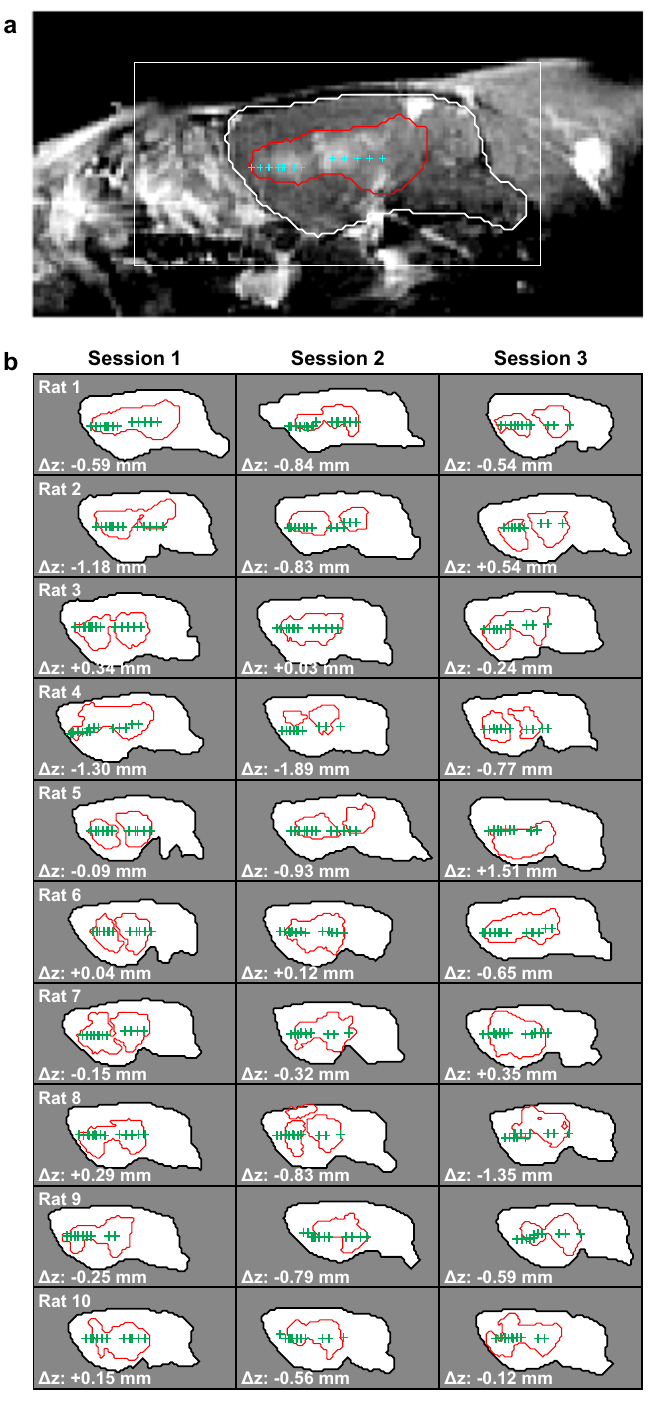
Figure 7. ( a ) Sagittal contrast-enhanced T1-weighted MRI showing BBB disruption, evident in the area outlined in red. The targets that were within ± 1 mm of this image plane are shown, and the brain is segmented with a white contour. ( b ) Segmentations of the brain and the area with evident BBB disruption for 30 consecutive sessions. The targets are indicated. In most cases, the extent of the BBB disruption was contained within the brain. In a few cases, the disruption reached the brain surface proximal to the transducer. The distance between the average depth of the segmented BBB disruption and the target plane was less than one millimeter in 25/30